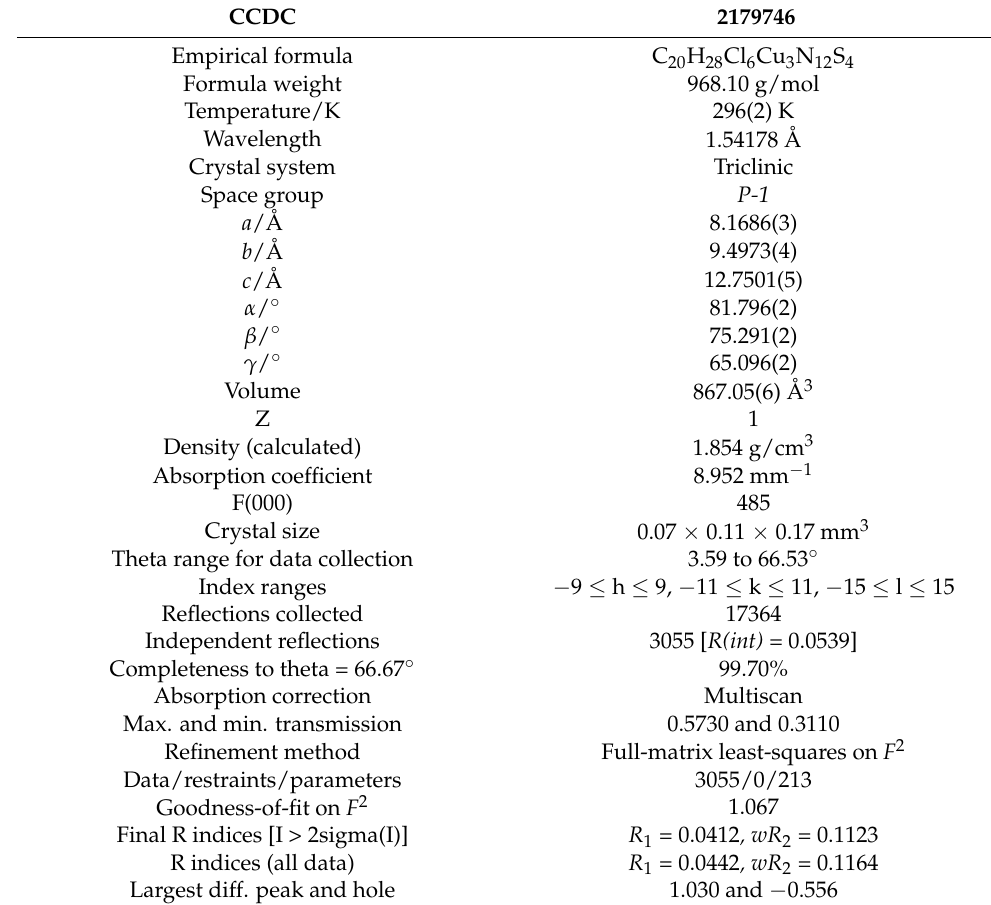
Table 1. Refinement details of the trinuclear [Cu 3 (L a ) 4 (Cl) 6 ]